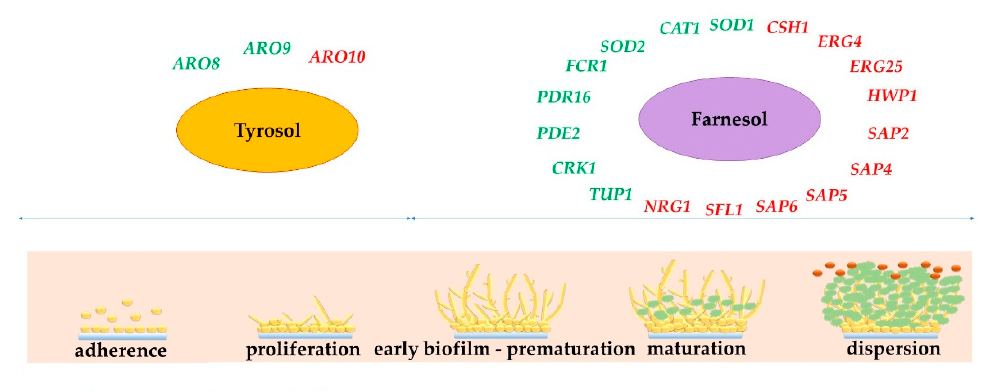
Figure 5. Genes participating in biofilm formation impacted by Far and Tyr.